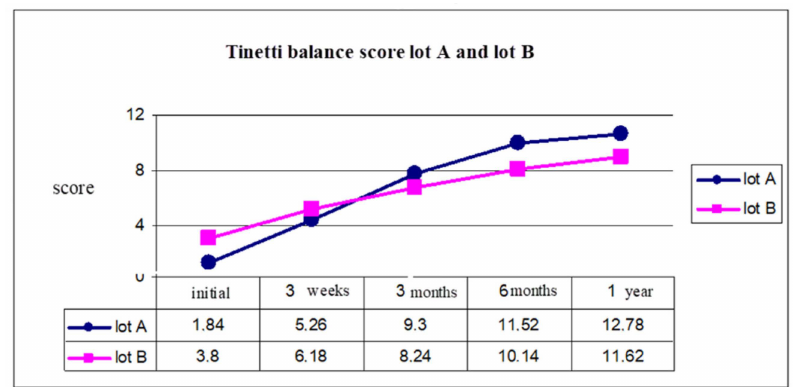
Figure 5. Tinetti balance score group A and group B.